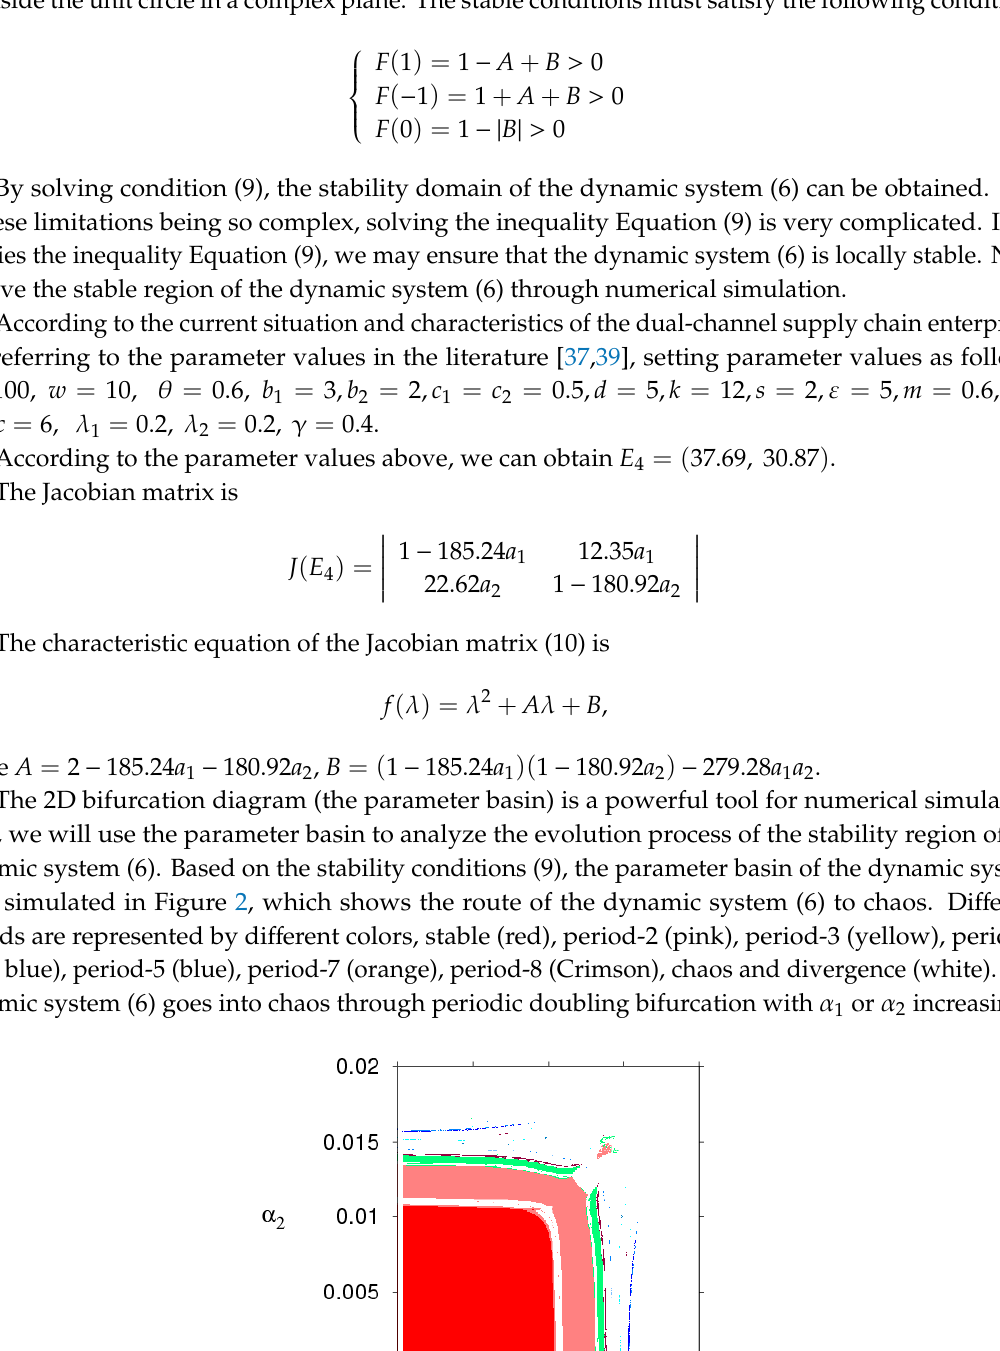
Figure 2. The evolution process of dynamic system (6) in the ( 𝛼 (cid:2869) , 𝛼 (cid:2870) ) plane.